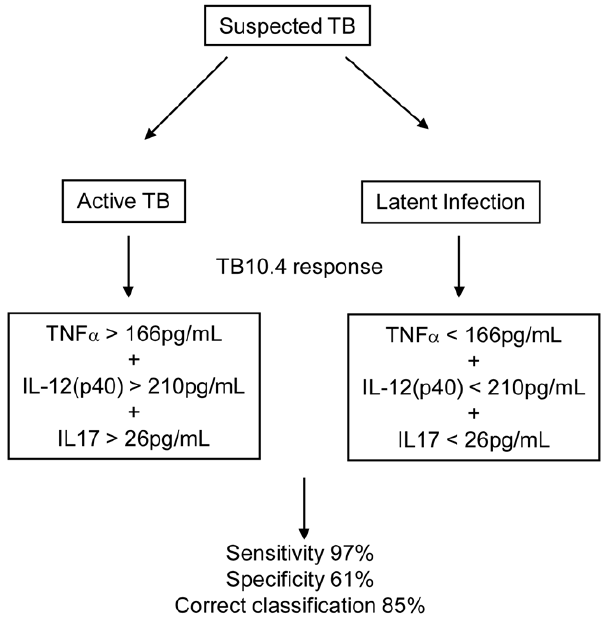
Figure 4. Flow chart demonstrating how cytokine production following TB10.4 stimulation will improve diagnosis of active TB. At the moment, patients with suspected TB may be confirmed by analysis of chest x-ray (CXR) plus sputum culture positivity in laboratories which have these capabilities. Analysis of TNF- a , IL- 12(p40) and IL-17 production following TB10.4 stimulation should suspected TB but smear/culture negative results (such as HIV-positive patients or extrapulmonary TB patients). These findings should